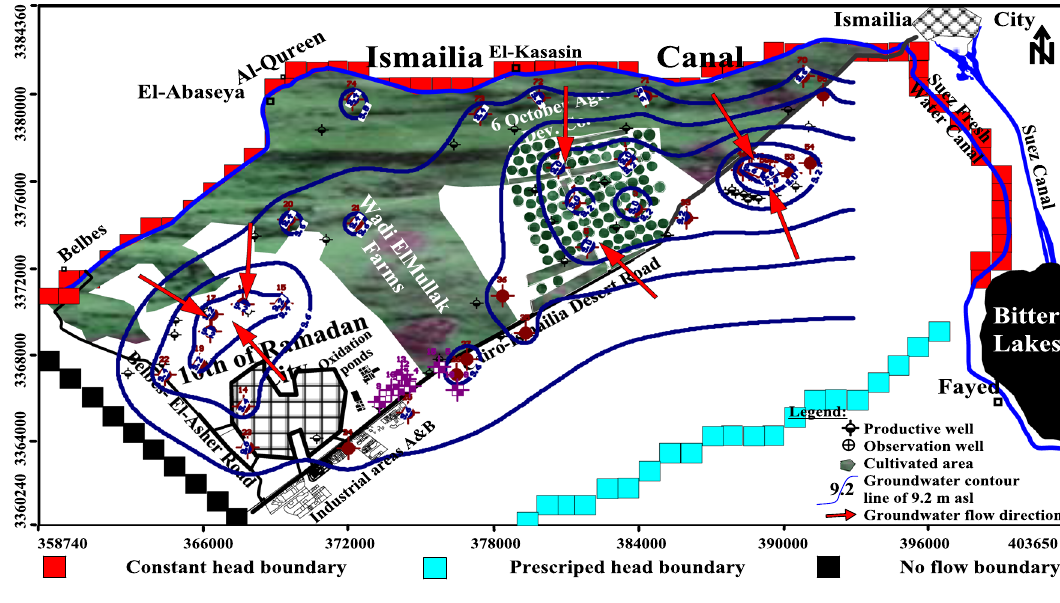
Fig. 8 Predicted head after 10 years of the simulation in Quaternary aquifer